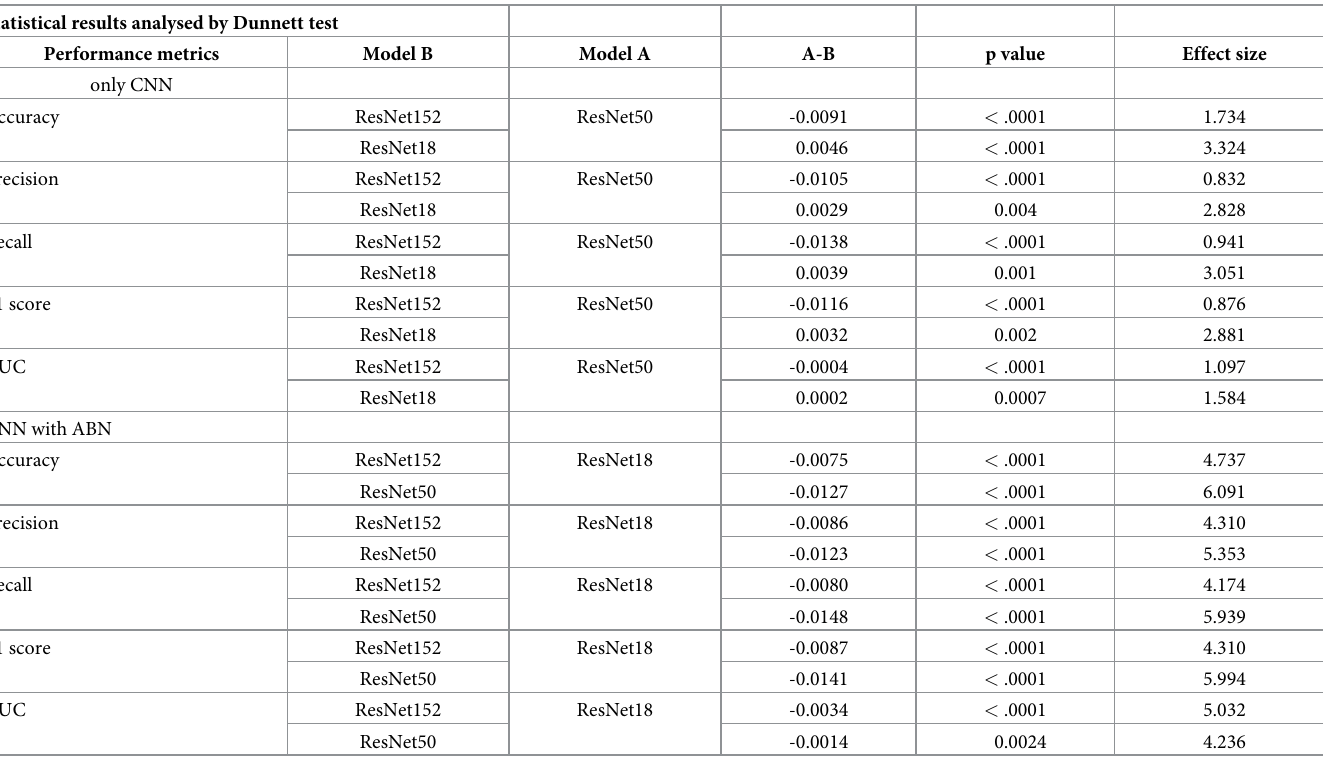
Table 5. Multiple comparisons of models with different numbers of layers for simple CNNs and CNNs with ABN; statistical results analyzed by Dunnett’s